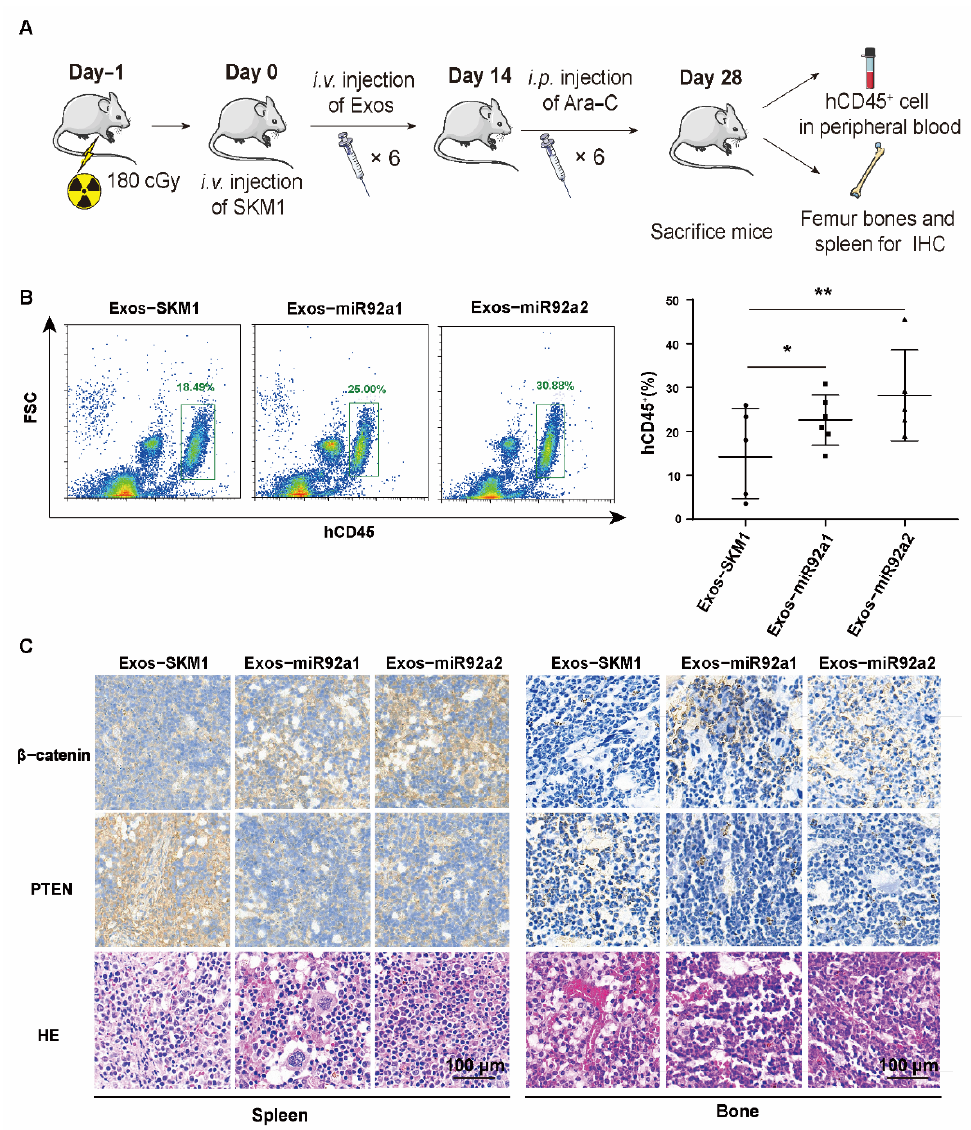
Figure 5. Exosomal miR92a promoted MDS/AML resistance in Ara-C in vivo. ( A ) Schematic diagram of the process for establishing mouse model. Adult NSG mice were irradiated with 180 cGy and injected with 2 × 10 6 SKM1 cells by intravenous injection. After SKM1 injection, 1.5 mg/kg Exos-SKM1, Exos-miR92a1 or Exos-miR92a1 was injected intravenously 6 times. An amount of 80 mg/kg Ara-C was injected intraperitoneally three times a week after SKM1 injection for 14 days. The peripheral blood was analyzed by flow cytometry on day 28. ( B ) Percentages of SKM1 (hCD45 + ) in peripheral blood of mice injected with Exos-SKM1 or Exos-miRNA92a1/2 and Ara-C. ( C ) β -catenin and PTEN level in the spleen and bone tissues detected by IHC staining. Scala bar = 100 µ m, * p < 0.05, ** p <